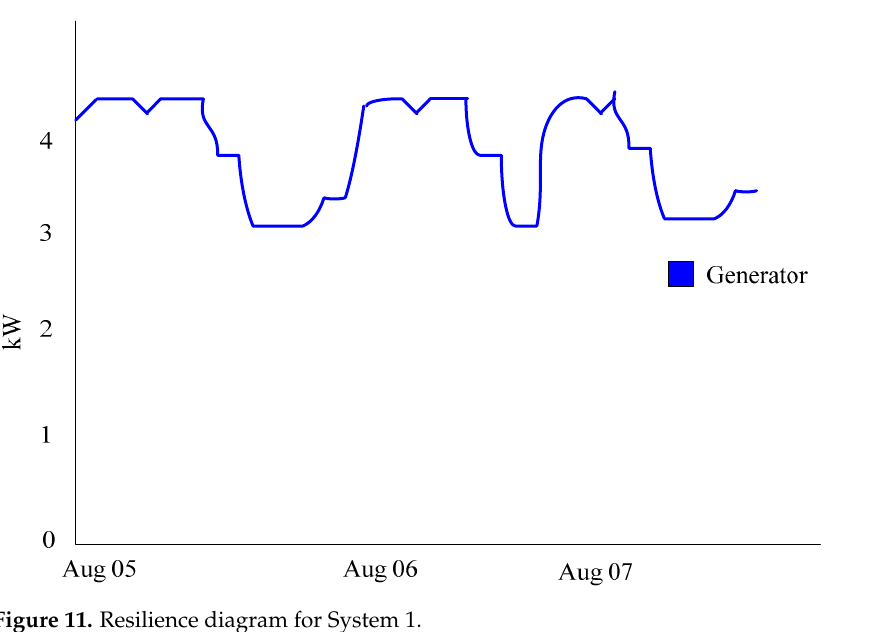
Figure 11. Resilience diagram for System 1.